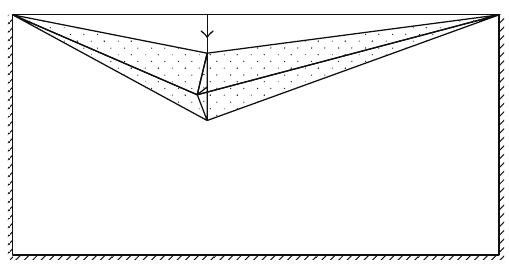
Figure 3: Illustrations for the second